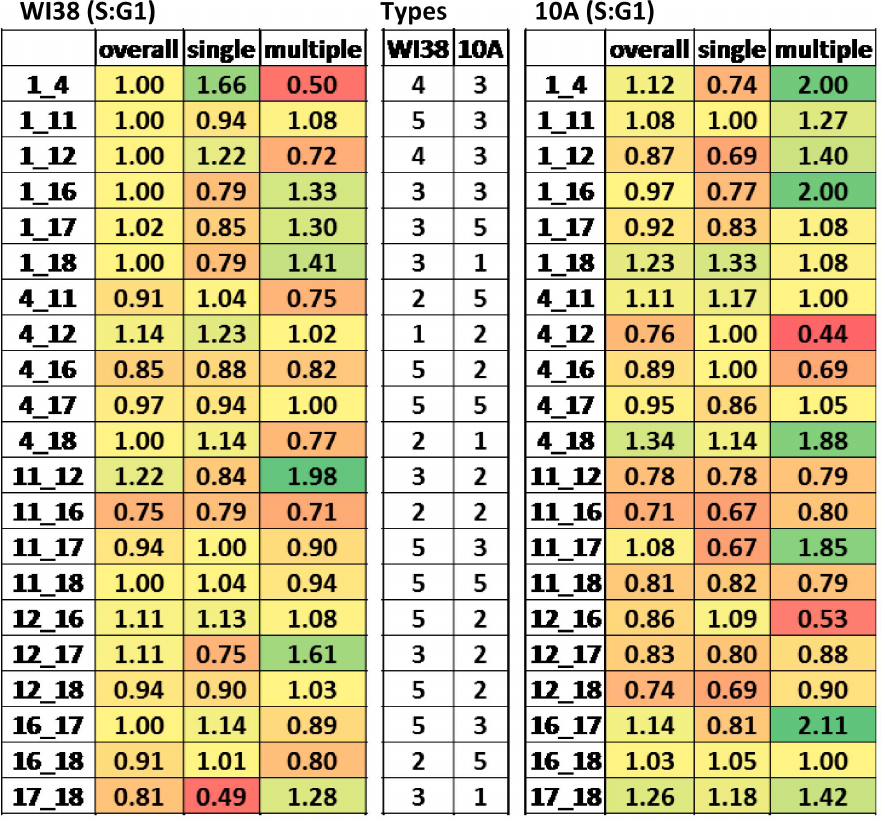
Figure 3. Alterations in interaction profiles from G1 to S phase. Calculation of the ratio between pairwise CT (S:G1) reveals different alterations of CT interactions from G1 to S. Some alterations demonstrate an overall increase (type 1) in interaction while others have an overall decrease in interaction (type 2). Others switch from having greater levels with a singular interaction to those with more nuclei with multiple interactions (type 3) or vice versa (type 4). Others do not change from G1 to S (type 5). Values are color coded with green increasing the most from G1 to S and red decreasing the most. The types of alterations in interaction are displayed for WI38 and 10A in the center rows.